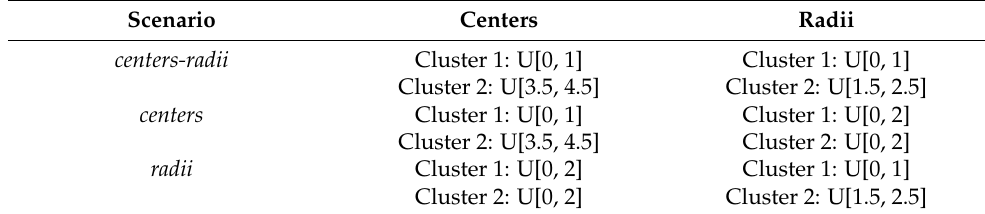
Table 2. Data generation in the simulation